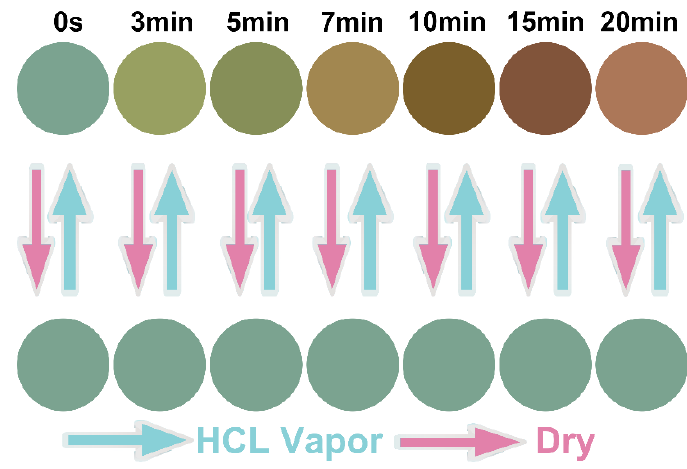
Figure 7. Reversible stimulation response to hydrochloric acid gas of CNC-glycerol composite films. The color change in the films under different times of hydrochloric acid gas stimulation was demonstrated. After drying, the film can return to its original color.